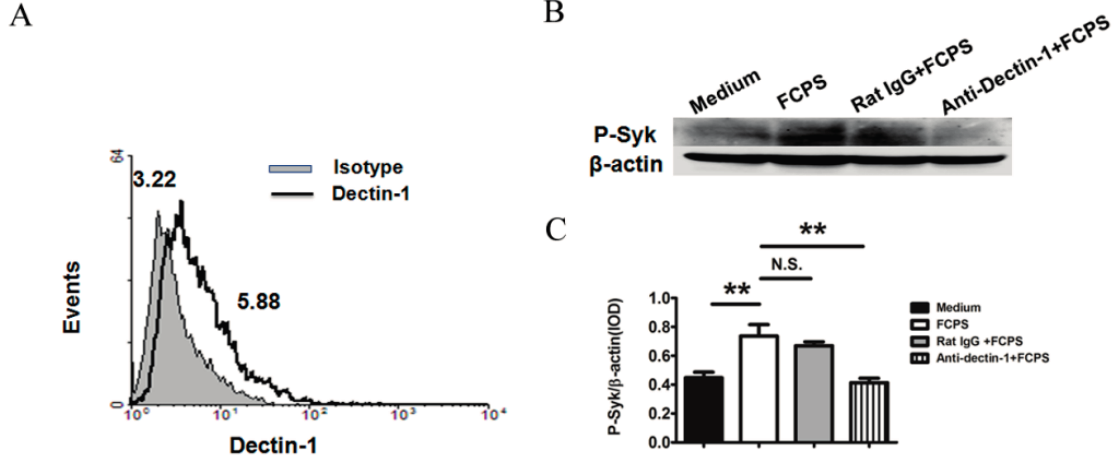
Figure 1. FCPS activate Syk via dectin-1 in BMDCs. ( A ) Expression of dectin-1 on BMDCs. Anti-dectin-1 antibody (thick line) or rat IgG2b (solid gray) were used to stain dectin-1 on BMDCs and then analyzed by flow cytometry; ( B , C ) Syk was activated after FCPS stimulation via the dectin-1 pathway; ( B ) Cells were stimulated with FCPS (100 μ g/mL) and dectin-1 was blocked with an anti-dectin-1 antibody (5 μ g/mL). Cells were lysed and P-Syk levels (upper band) were analyzed by western blot with β -actin as a loading control (lower band); ( C ) Quantitation of the P-Syk/ β -actin ratio. Results are shown as means ± SD from three independent experiments. ** p < 0.01, N.S. no